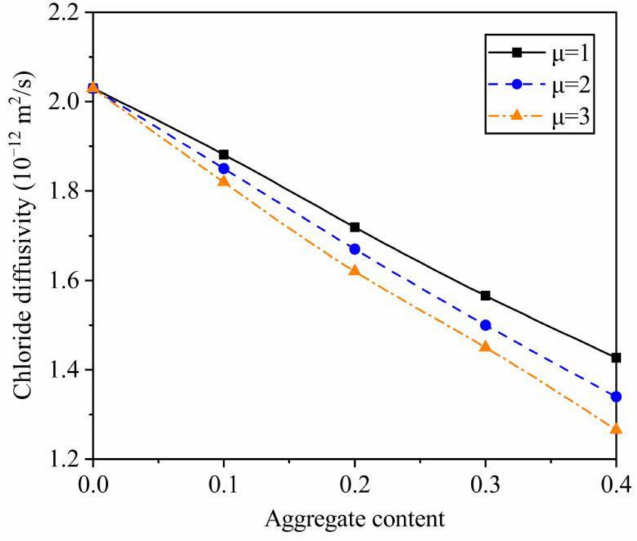
Figure 7. The impact of µ on D c